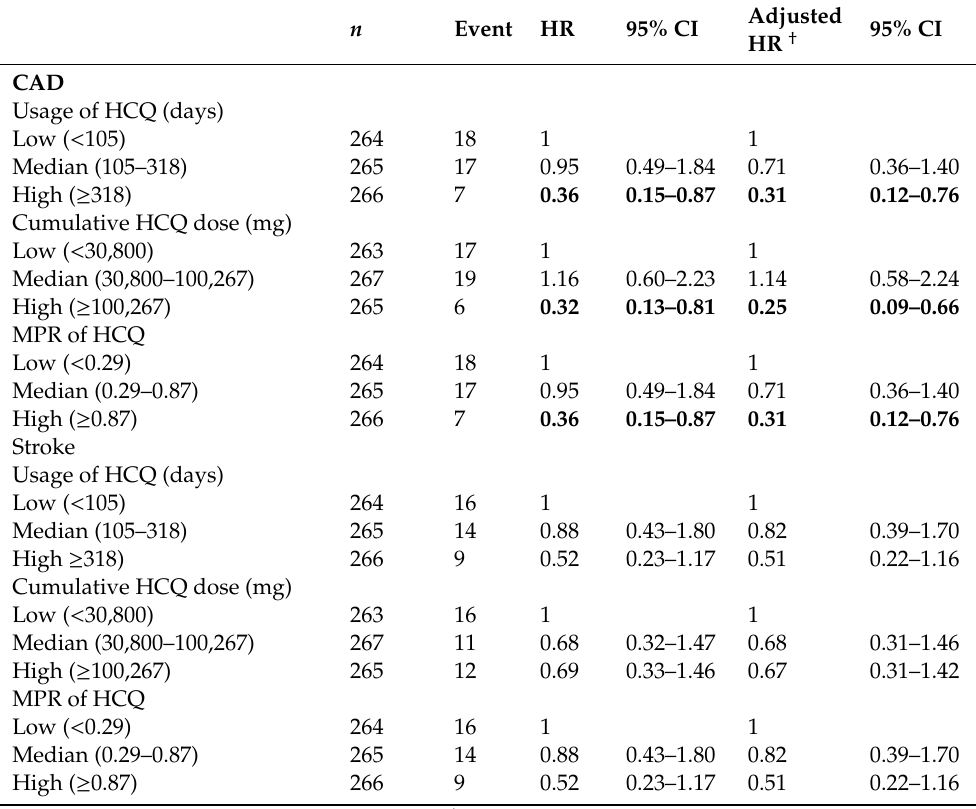
Table 4. HRs of CAD and stroke in SLE patients treated with